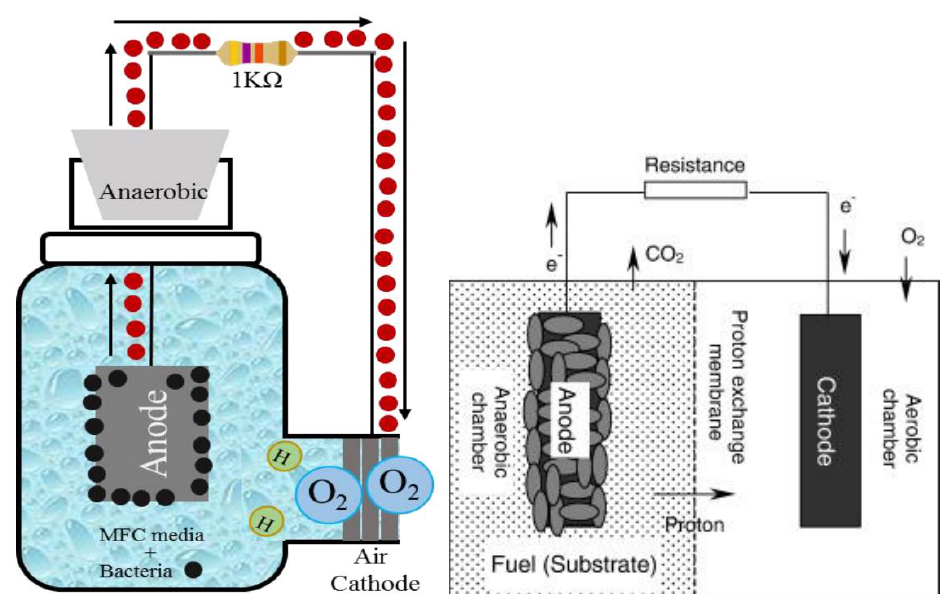
Figure 4. ( Left ) A conceptual diagram of a membrane-less single-chamber MFC (Reprinted with permission from Ref. [54]), ( Right ) A two-compartment MFC that can be used in food waste treatment (Reprinted with permission from Ref. [55]).